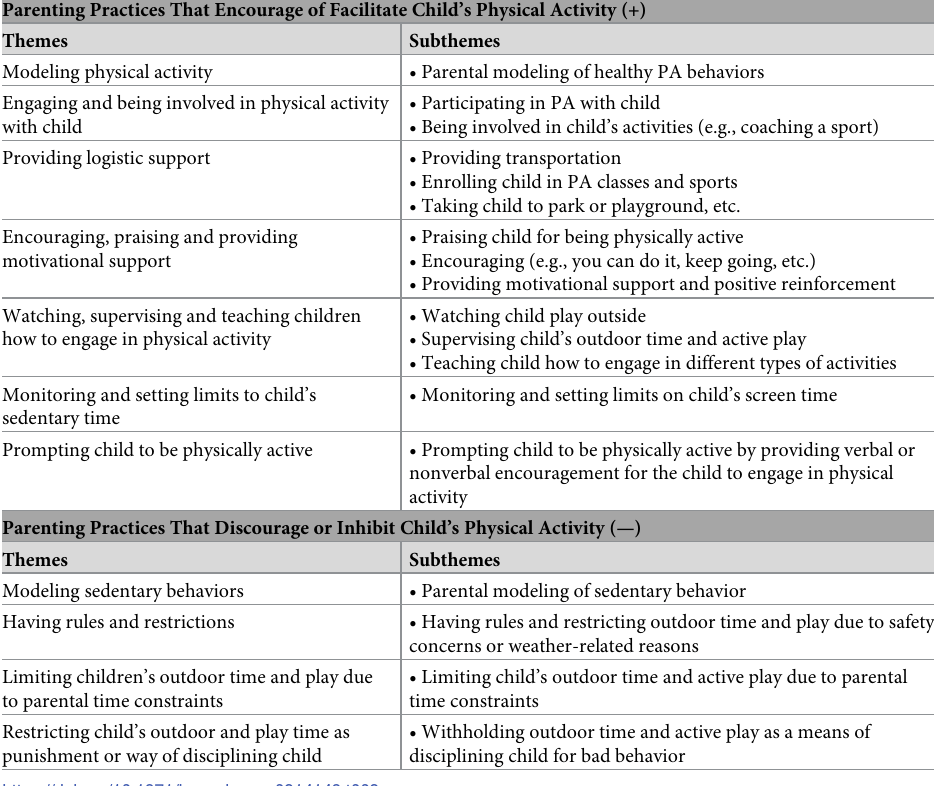
Table 2. Parenting practices used by Brazilian immigrant mothers living in the United States that encourage and discourage their preschool-aged children to be physically active. Parenting Practices That Encourage of Facilitate Child’s Physical Activity